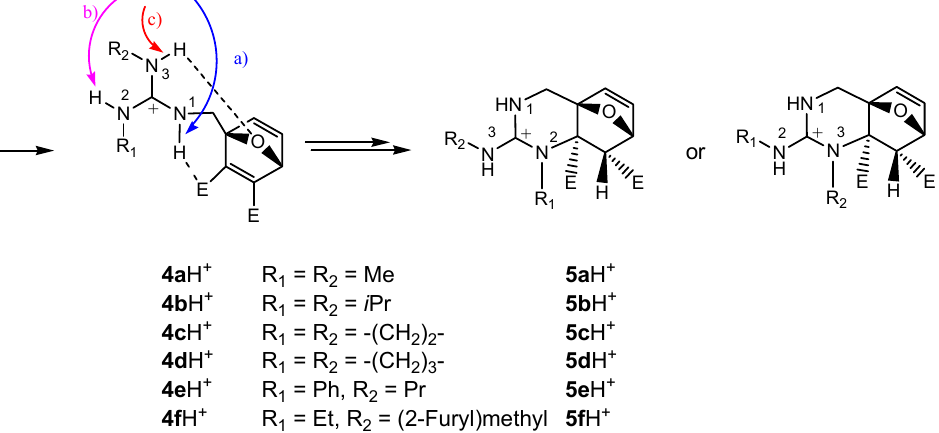
Scheme 2. Cyclization of guanidinium-substituted oxanorbornadienes ( 4x H + ) with indicated differ- ent positions for the hydrogen bonding/partial deprotonation. Anions were deliberately neglected from the calculations. Table 2. Calculated ACN p K a s for all three positions in the guanidine subunit and the Gibbs energies of the reaction for the cycloaddition and cyclization of the oxanorbornadiene ions 4a H + – 4f H + .